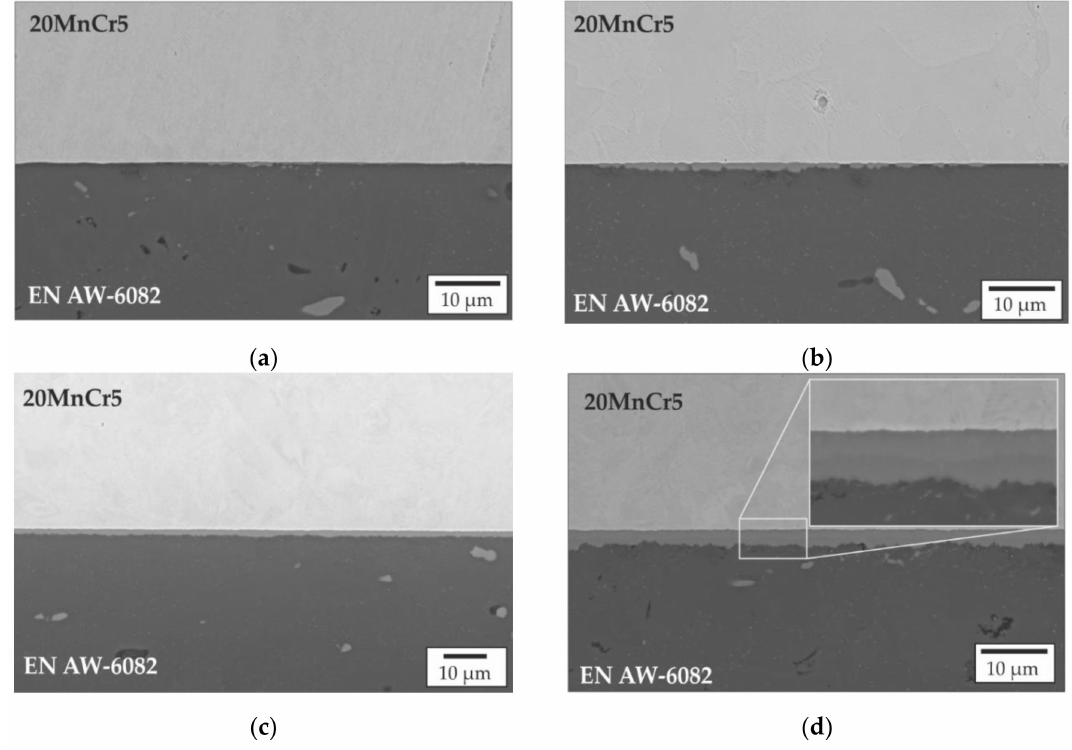
Figure 5. SEM images of the resulting joining zones formed in the analogy experiments at a forming temperature of 560 ◦ C, a force of 5890 N and a forming time of ( a ) 30 s, ( b ) 60 s, ( c ) 120 s and ( d ) 240